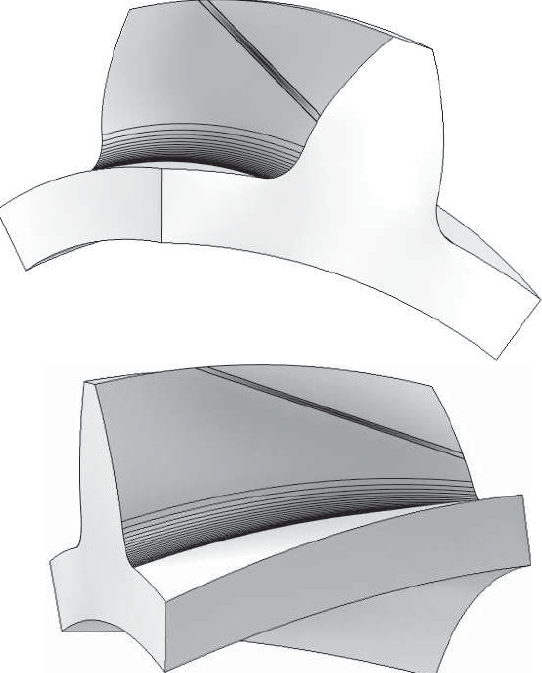
Figure 1: Example of loaded helical gear tooth. The contact is here illustrated to lie between the two lines on the tooth face.